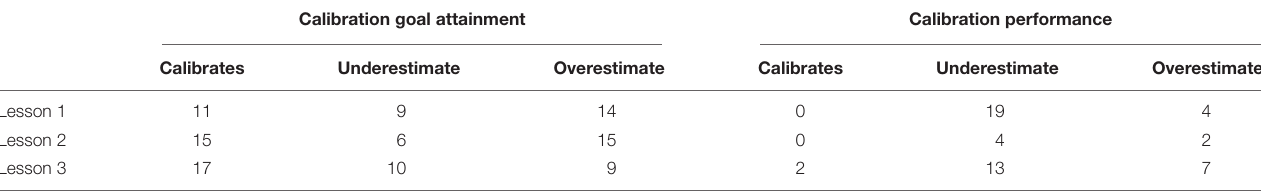
TABLE A1 | Overview of number of learners that calibrated, over or underestimated on goal attainment and performance. Calibration goal attainment Calibration performance Calibrates Underestimate Overestimate Calibrates Underestimate Overestimate